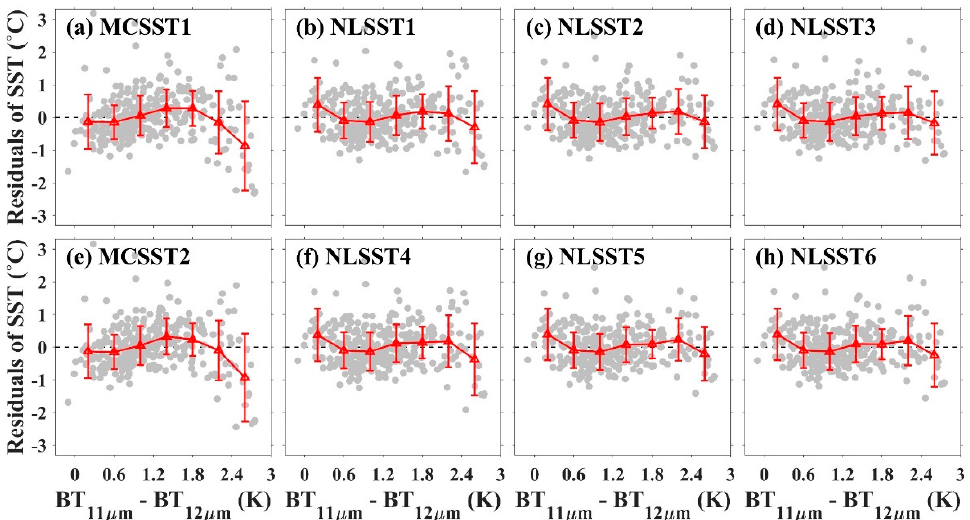
Figure 9. Comparison of residuals (Landsat 8 OLI / TIRS SST – buoy SST) using ( a ) MCSST1, ( b ) NLSST1, ( c ) NLSST2, ( d ) NLSST3, ( e ) MCSST2, ( f ) NLSST4, ( g ) NLSST5, and ( h ) NLSST6 with brightness temperature di ff erence between 11 µ m and 12 µ m, where the red points and bars represent the mean value and standard deviation of SST errors for each interval, respectively.